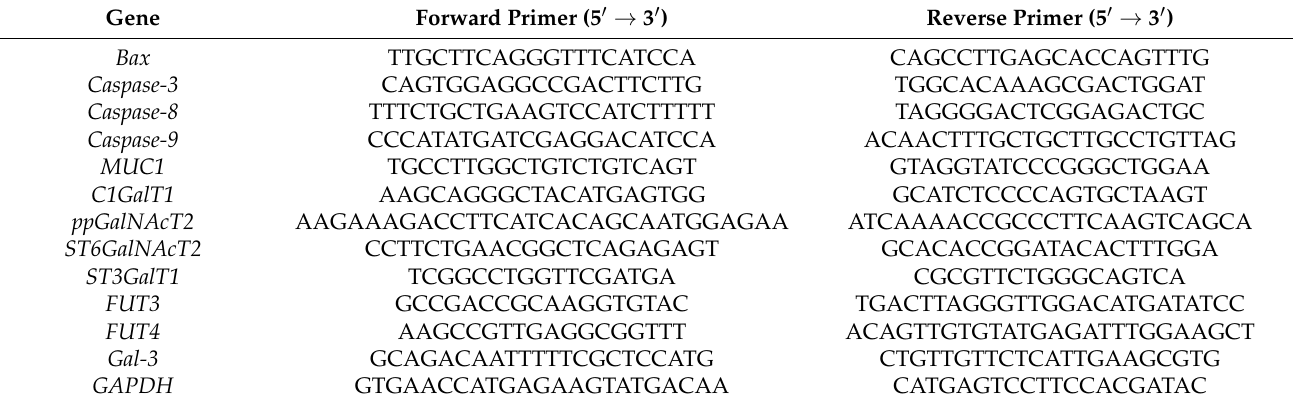
Table 2. Sequences of primers used for